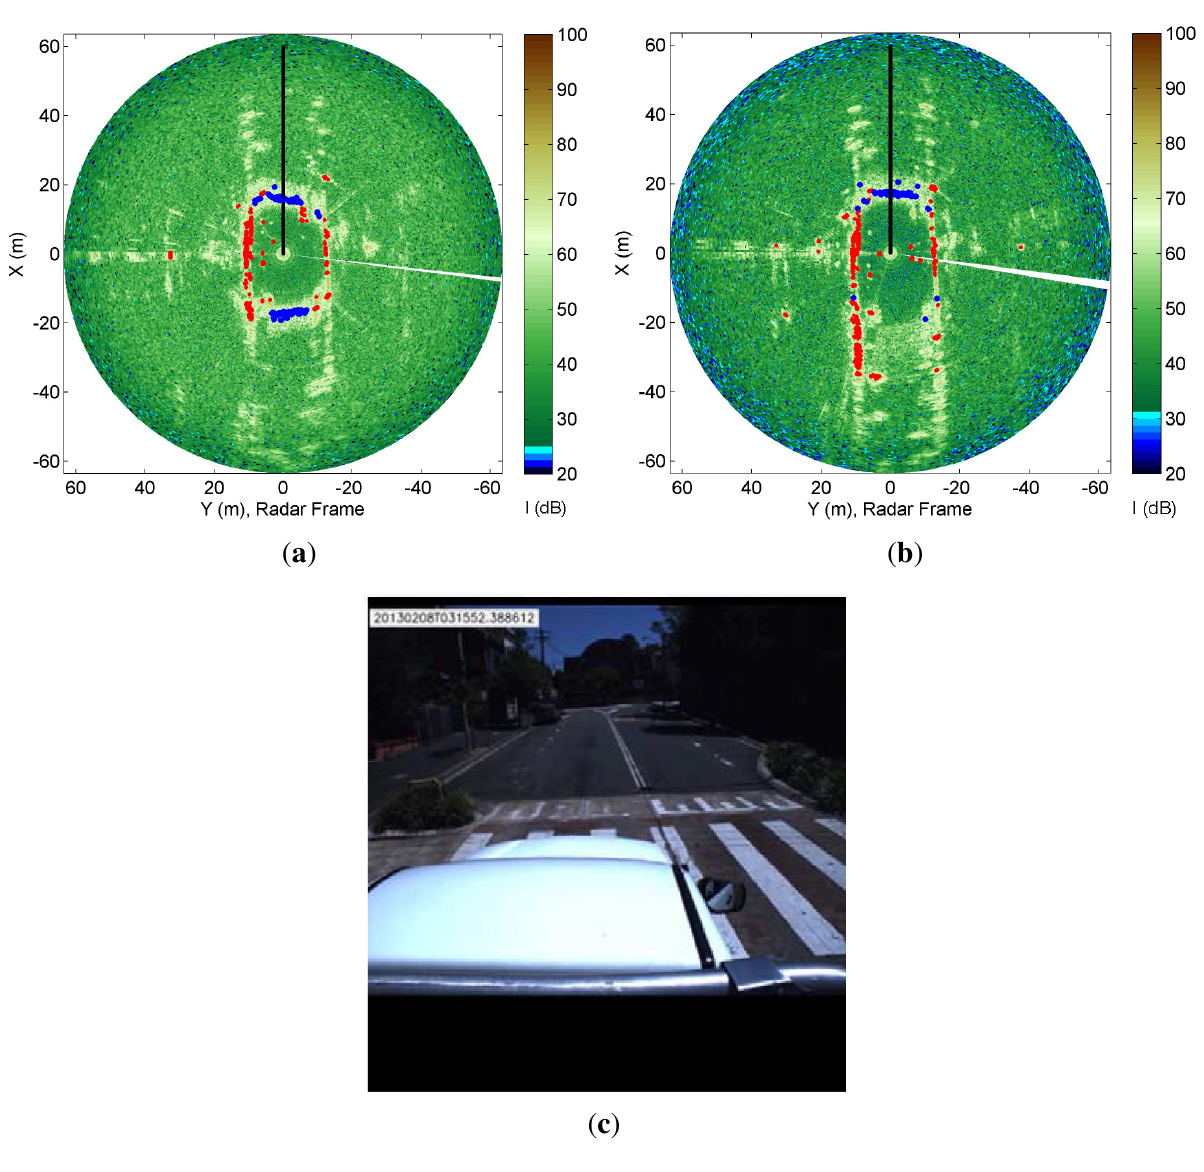
Figure 12. Sequence of the radar images superimposed with the RCGD results ( a ) and ( b ); Results obtained from the RCGD method after the traverse of a hump ( c